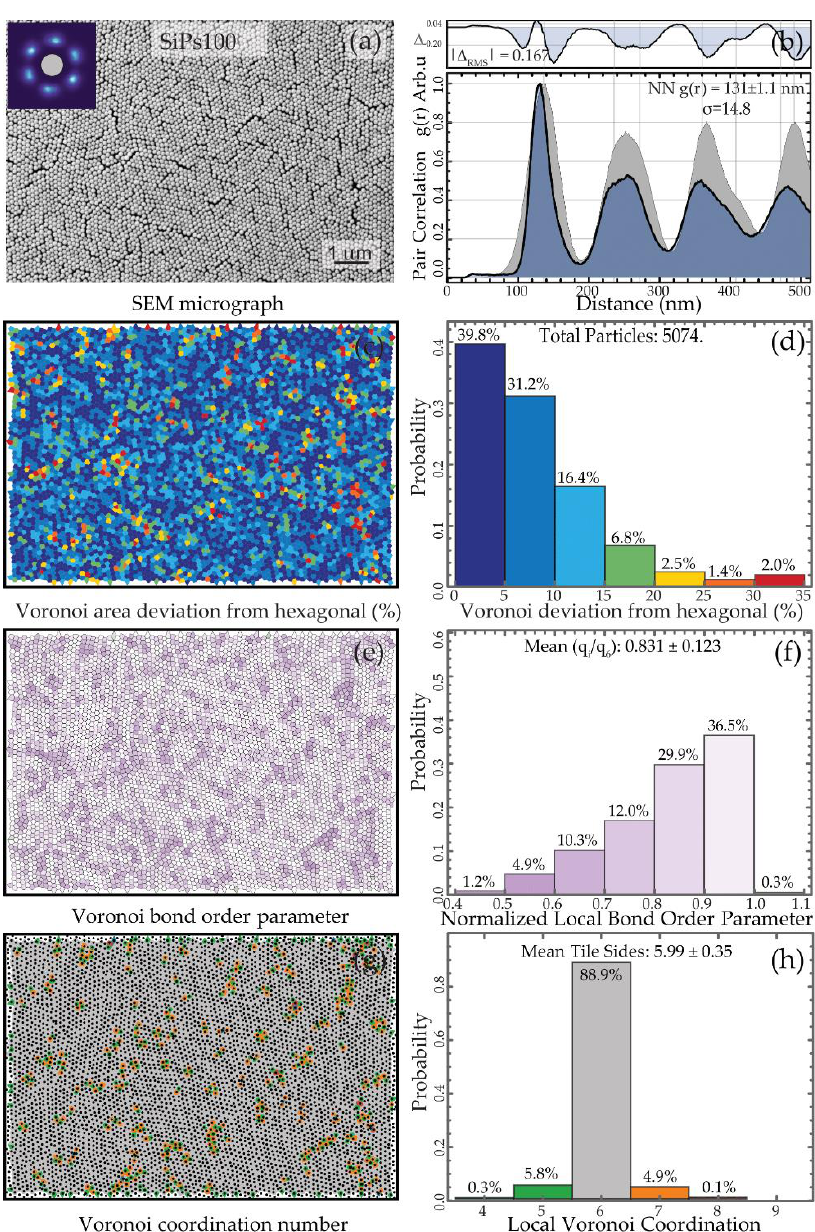
Figure A2. Spatial statistics of sedimented SiPs100. ( a ) SEM image with insert of coordination map or fast Fourier transform (FFT) showing six distinct lobes as expected for hexagonally packed systems. ( b ) pair correlation function for the particle distributions (blue) and that of the matched hexatic lattice (grey). Using the average spacing (2r hex ) of a hexagonal lattice with the same number density (located at particle positions), the matched hexatic lattice is determined by randomly displacing the particles from their center with a mean distance relative to a normal probability distribution. The widths of these peaks correspond to the average mean displacement each particle has relative to this expected spacing, described by the lattice disorder parameter, σ . The nearest neighbor distance can be determined from the maximum of the first peak in the g(r) . The insert above shows the difference spectrum, which is the subtraction between the pair correlation function and the hexatic lattice. ( c ) Voronoi tessellations of the particle centroids colored by percent deviation of the expected cell area produced from hexagonal packing. ( d ) Histogram of the probabilities of various percent deviations of the Voronoi cell areas from those produced from hexago- nal packing. Taking into account cells with packing of less than 15% of a perfect hexagonal lattice (three blue bars), the film shows ~87% hexagonal packing regions. ( e ) Voronoi tessellations of the particle centroids colored by the normalized bond order parameter. Whiter areas indicate particles that have high angular order in a hexagonal ( q 6 ) symmetry basis. ( f ) Histogram of the probabilities